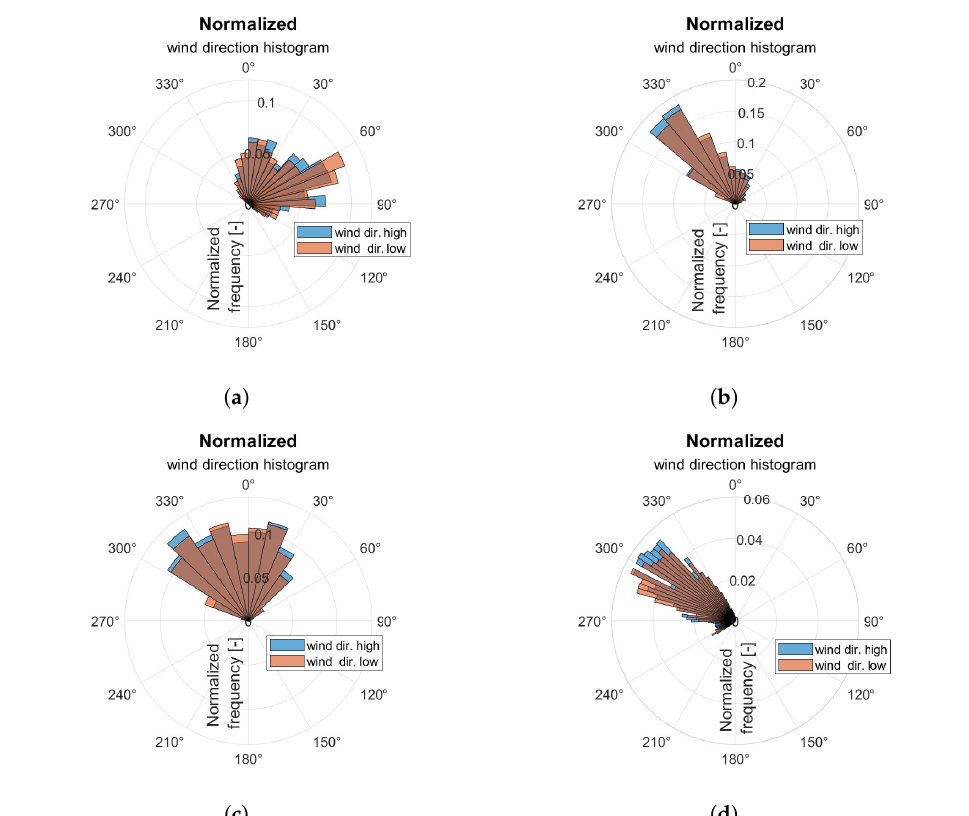
Figure 15. Normalized wind direction histograms for 2.5 h experiments: ( a ) week wind; ( b ) medium week wind; ( c ) medium strong wind; ( d ) strong